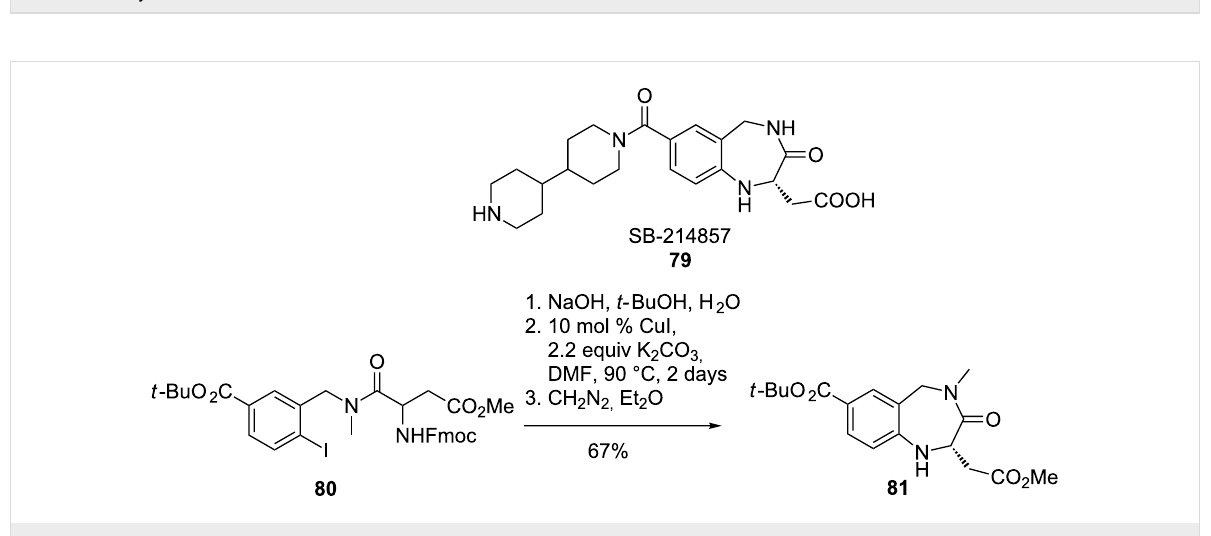
Scheme 19: Synthesis of an intermediate for lotrafiban (SB-214857).